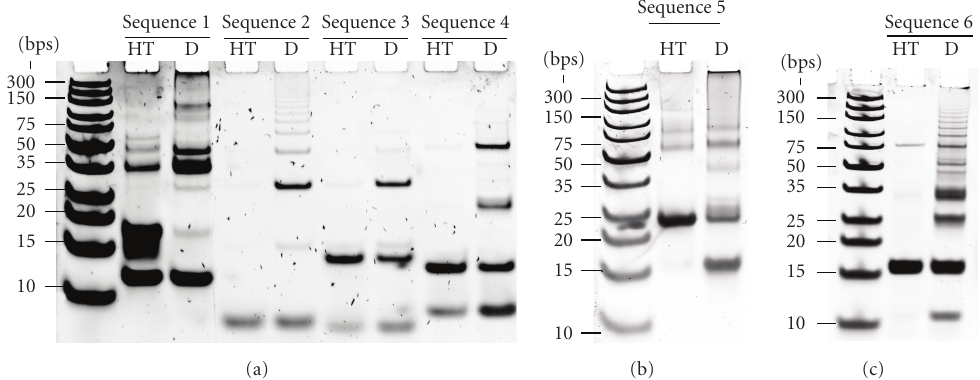
Figure 1: PAGE shows that heat treatment (HT) mainly gives short aggregates, while preparation by dialysis (D) results in higher degree of assembly. Most profound multistep assembling is observed for dialysed sequences 1, 5, and 6.